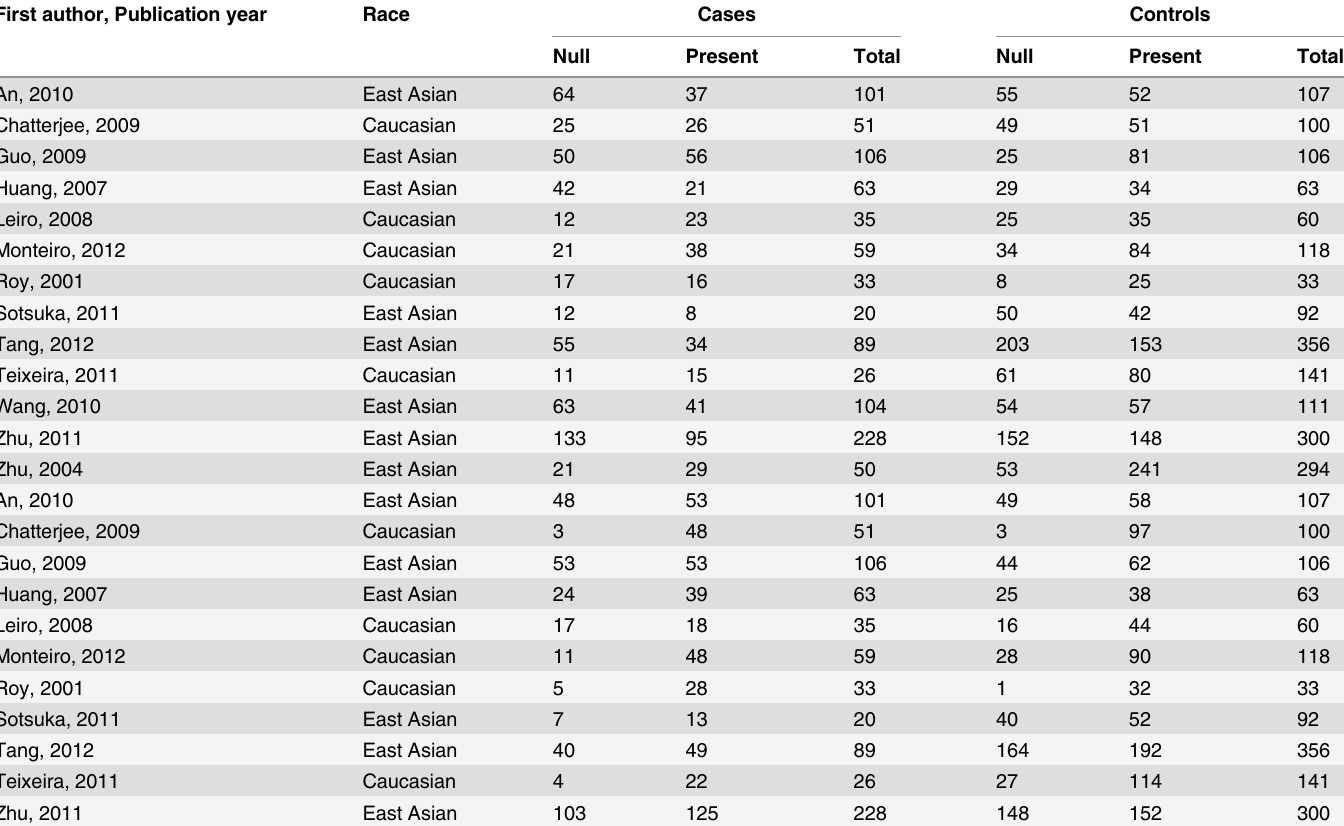
Table 1. Genotype distributions of GSTM1/T1 polymorphisms among ATDILI as cases and non-ATDILI as